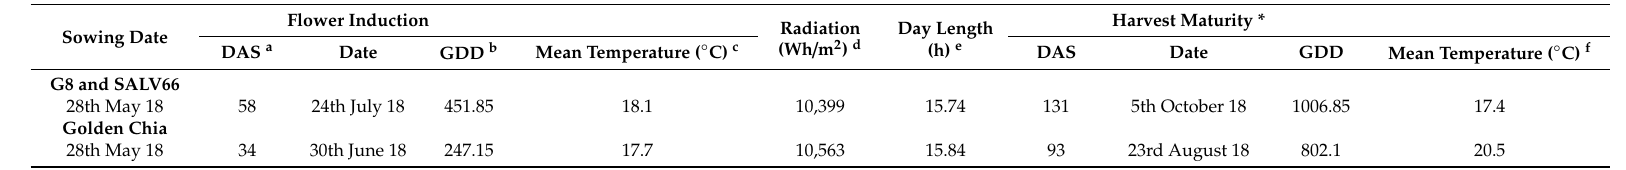
Table 3. Sowing dates, accumulated growing degree days (GDD), radiation, day length, and mean temperatures at Ihinger Hof (IHO) in 2018 for varieties G8, SALV66, and Golden